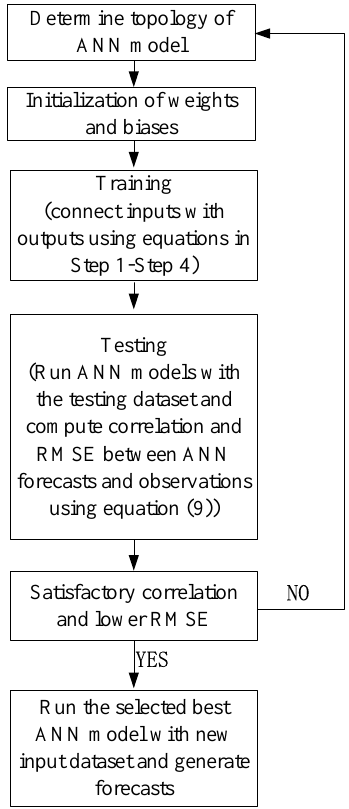
Figure 5. Flow chart of developing ANN models.